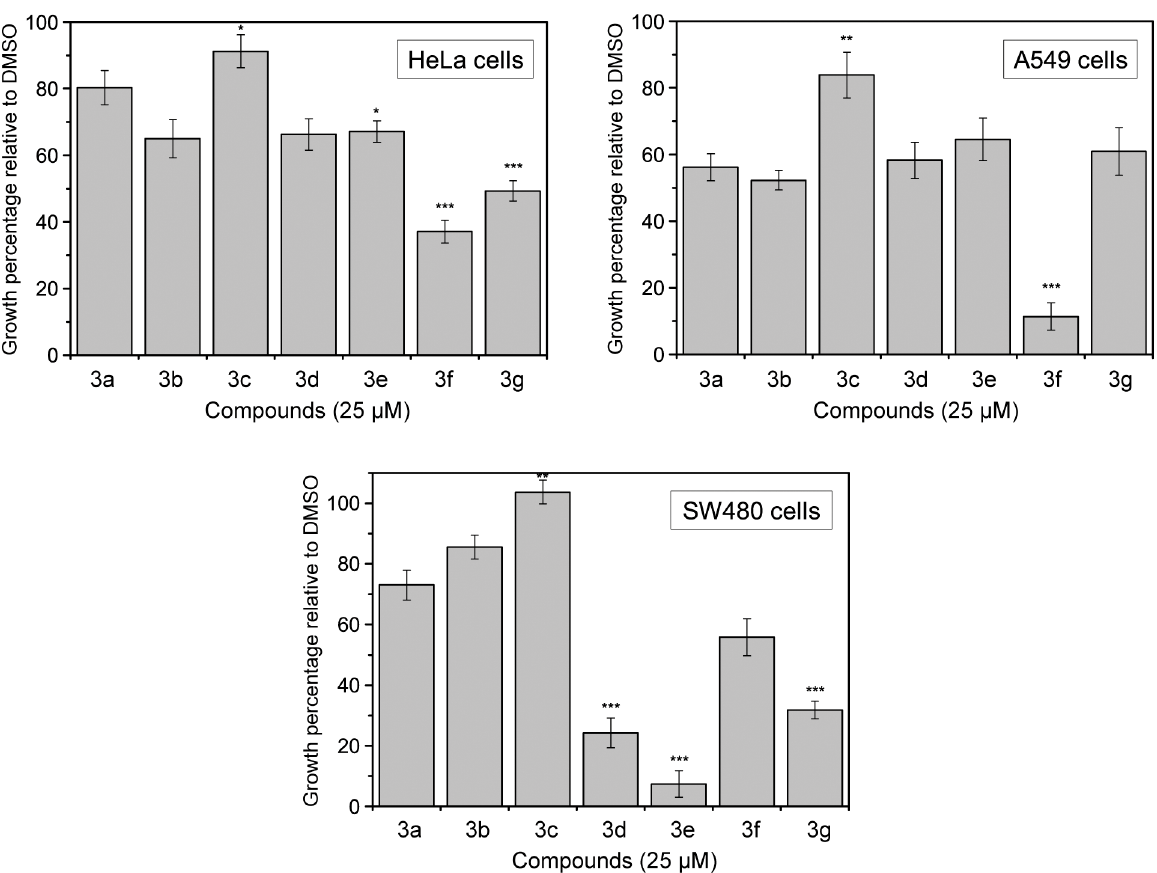
Figure 9. Results of the cytotoxicity assays. The cytotoxicities of compounds 3a – g are expressed as percentage of cell growth relative to the negative control. Error bars account for the standard error. Asterisks indicate statistically significant differences between a drug and the model compound 3a . Camptothecin was employed as a positive control (0% growth) at 25 and 2.5 m M concentrations.